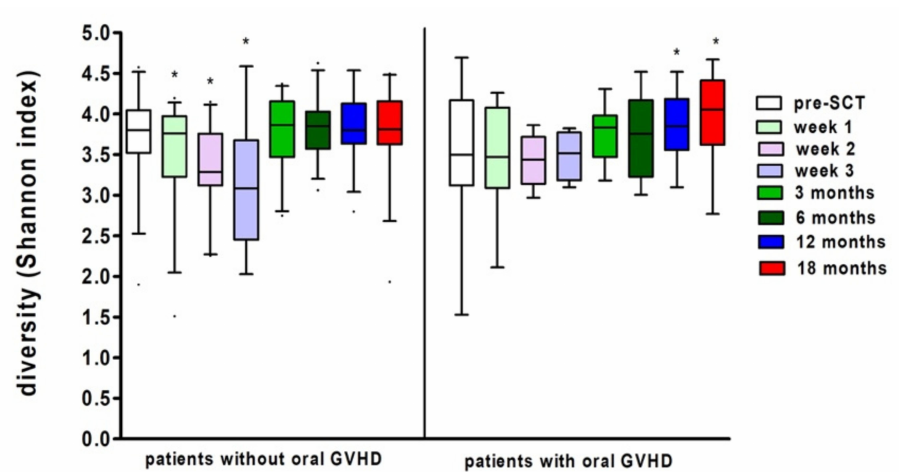
Figure 5. Shannon diversity index at several time points in patients with and without oral GVHD (median, 5–95 percentile). * Marks significant differences compared to pre-SCT (Linear Mixed Model Analysis, p < 0.05).